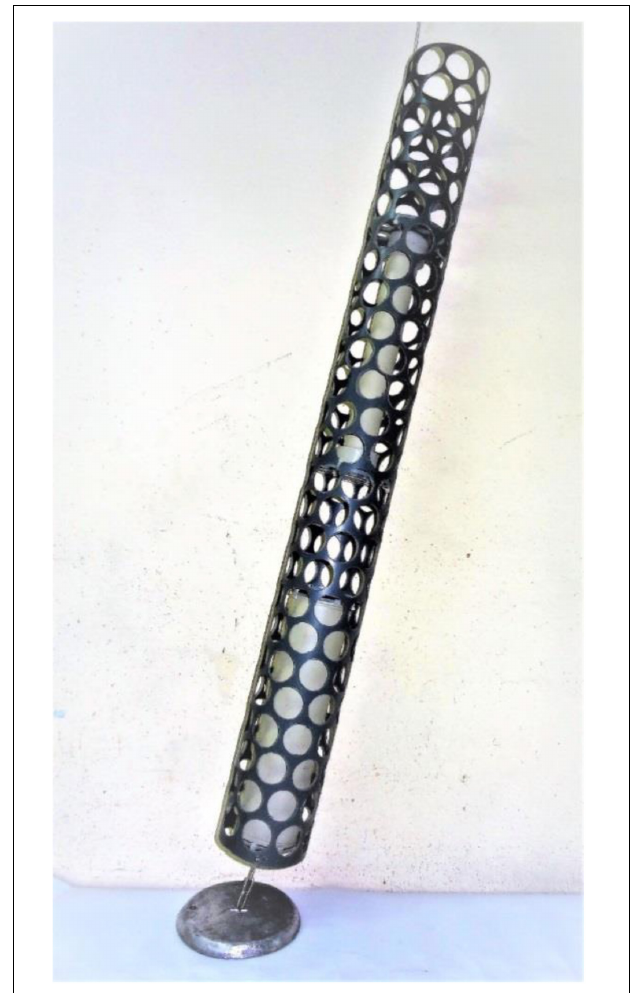
FIGURE 4 | A photograph of the TCM. Its shape is formed by a cylindrical perforated plastic pipe. Inside there are an instrument and buoyancy modules, and the entire floating package is attached to a lead plate by a piece of